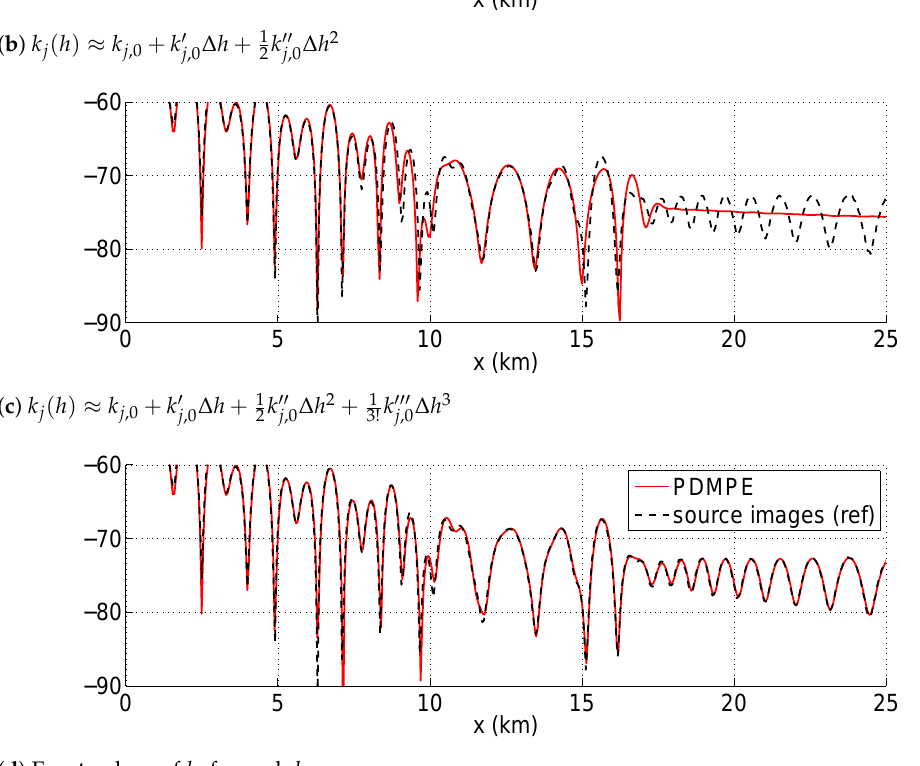
Figure 4. Acoustical field magnitude (in dB re 1 m from the source) in the coastal wedge as a function of x for y = 0, z = 30 m computed using pseudodifferential mode parabolic equations and (1) (red solid line). The reference solution by the method of source images is shown by the black dashed line. The slice of acoustical field P ( x , y , z ) by the horizontal plane z = z r = 30 m for the normal modes computed by the 3rd-order perturbation theory and the respective reference solution are shown in Figure